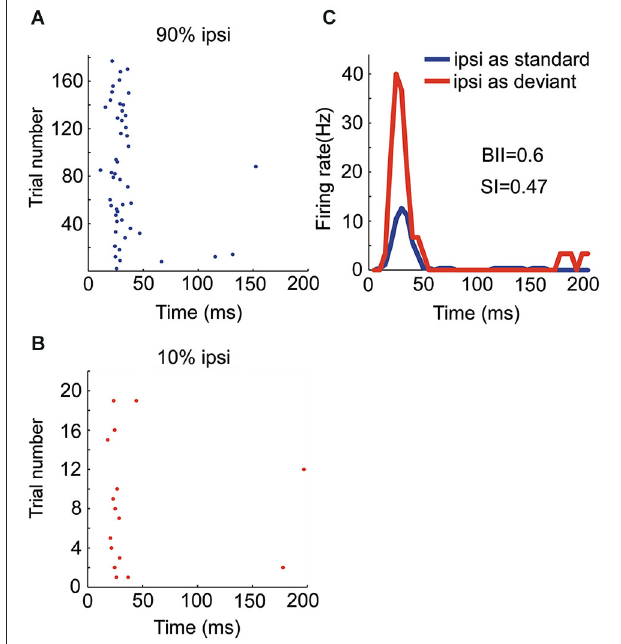
FIGURE 5 | Responses of an OE/I neuron to stimuli with two locations presented in oddball procedure. (A, B) Raster displays showing its responses to 180 times of standard (90% appearing probability) and 20 times of deviant (10% appearing probability) stimuli presented to the ipsilateral ear. (C) PSTH of responses shown in ( A and B